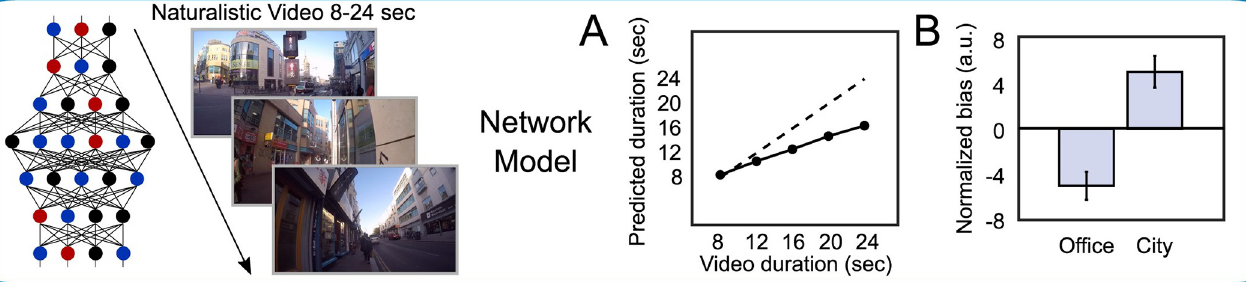
Fig 2. Artificial network model results. The same naturalistic videos (8–24 seconds in duration) that human participants viewed were input to an image classification network-based model to generate estimates of duration. (A) Relationship between presented and model-predicted video durations for this model, trained on accumulated salient events in video frames (solid line). The dashed line is the line of unity. (B) Relative under-/over- estimation of duration for office/city scenes for this model. Error bars represent SEM.